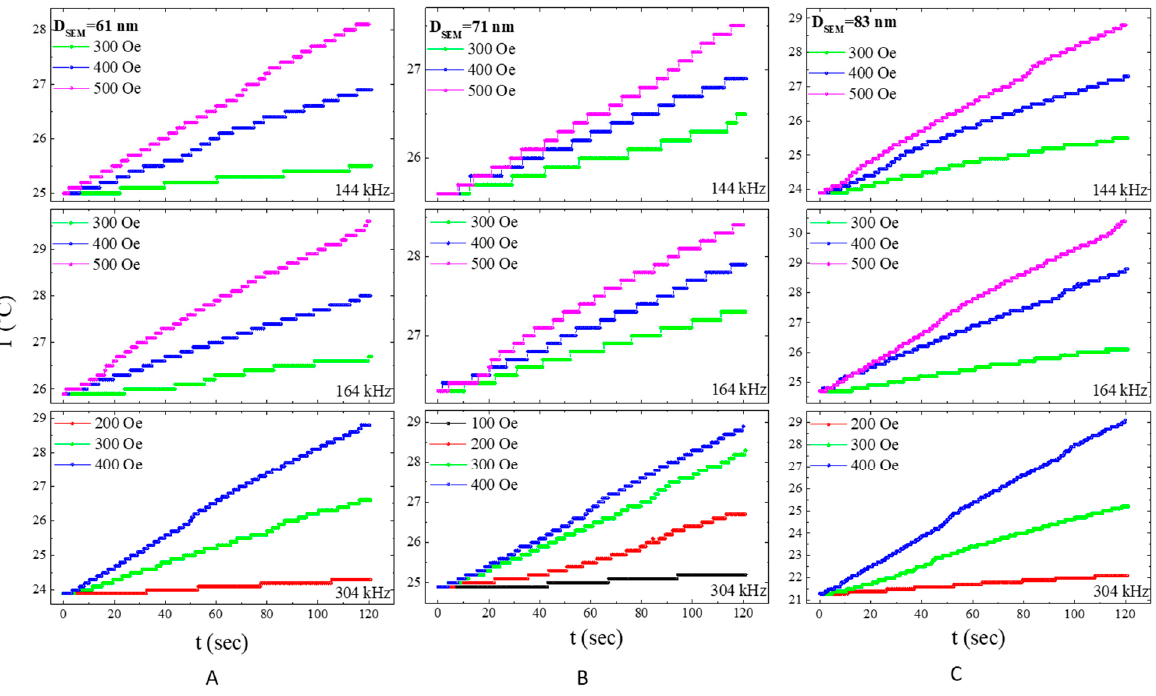
Figure 3. Temperature vs. time at different fields and frequencies for samples with sizes of ( A ) 61 nm, ( B ) 71 nm, ( C ) 83 nm.